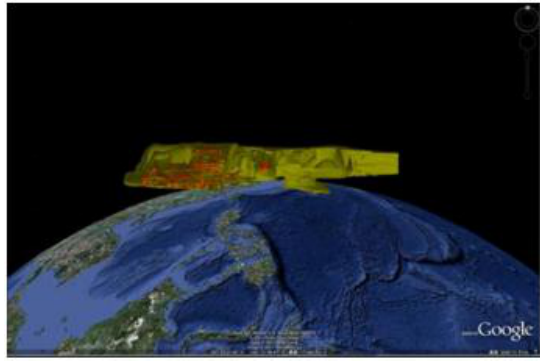
Fig.3 Asian dust cloud with dae format represented in the Google Earth